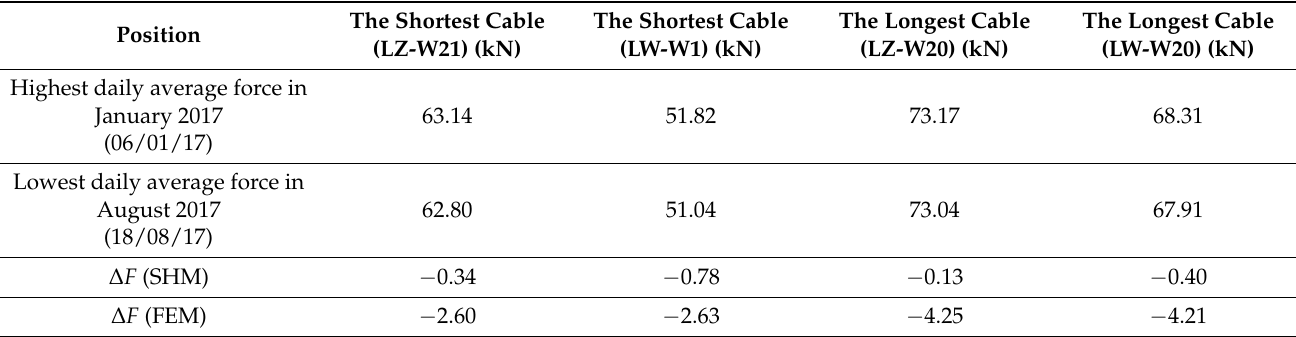
Table 6. Measured forces in strands of selected (the shortest and longest) cables compared with the calculated tension force change.